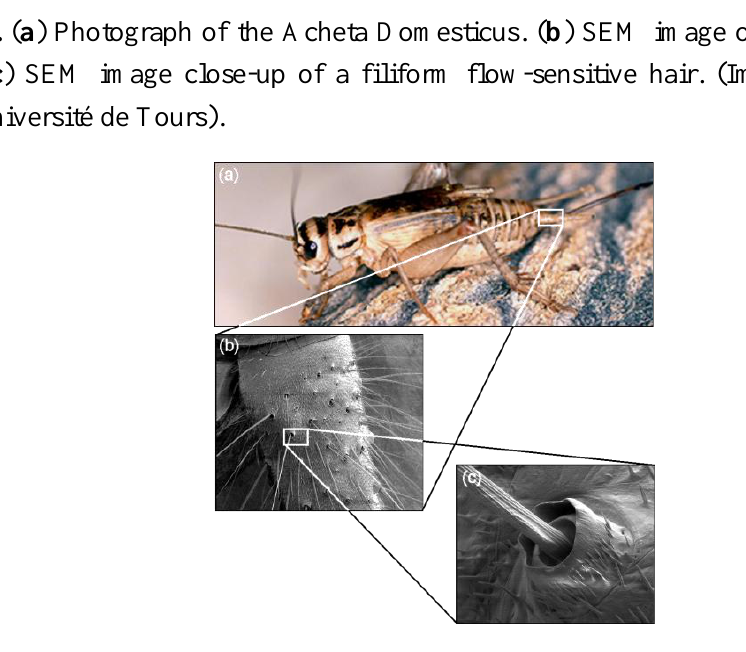
Figure 1. ( a ) Photograph of the Acheta Domesticus. ( b ) SEM image of the base part of